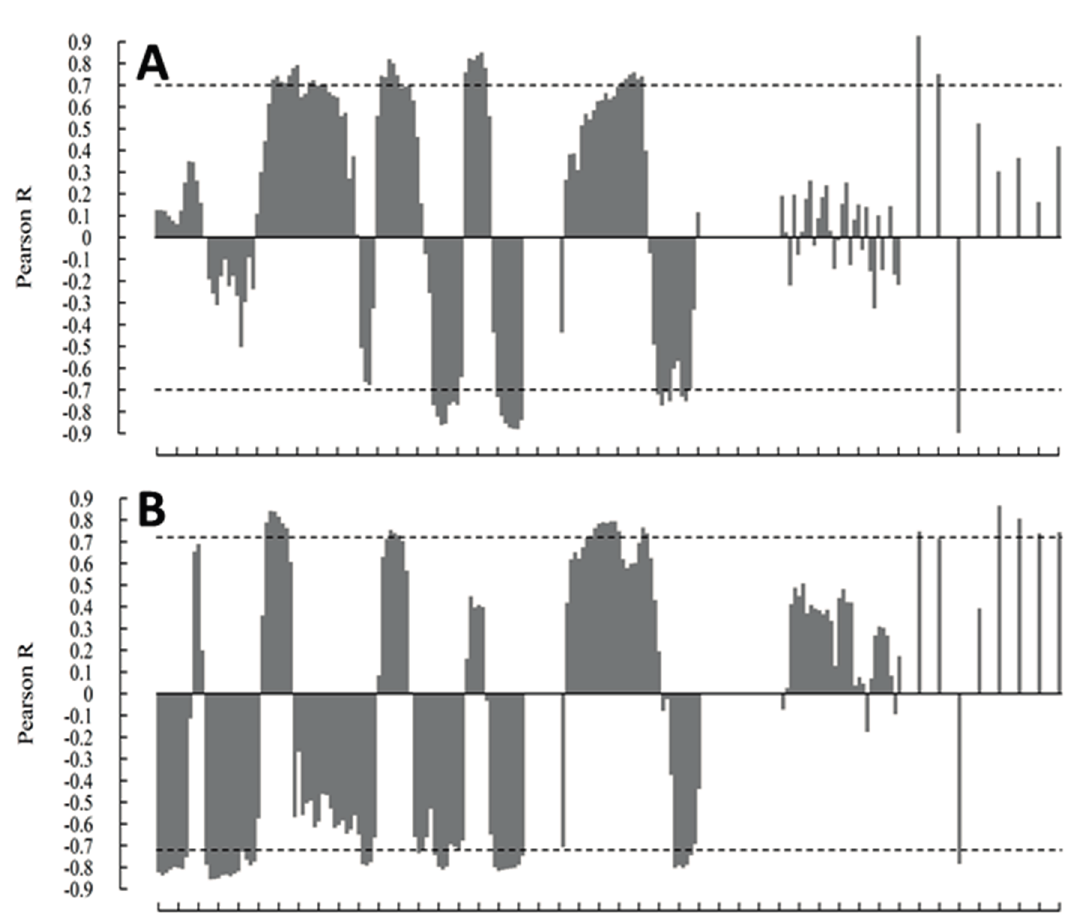
Figure 3. Pearson correlation between aboveground wet biomass and candidate non-spectral and untransformed spectral predictors for ( A ) rice, ( B ) alfalfa, ( C ) cotton, and ( D ) maize. The dashed line shows the threshold used to include predictors in the model-building phase. LAI is the leaf area index, β is the gap fraction, EXG is the excess greenness index, EXGR is the excess green minus excess red index, NDI is the normalized difference index, meanG is the mean chromatic greenness index, and medianG is the median chromatic greenness index. The hyperspectral narrowbands are in